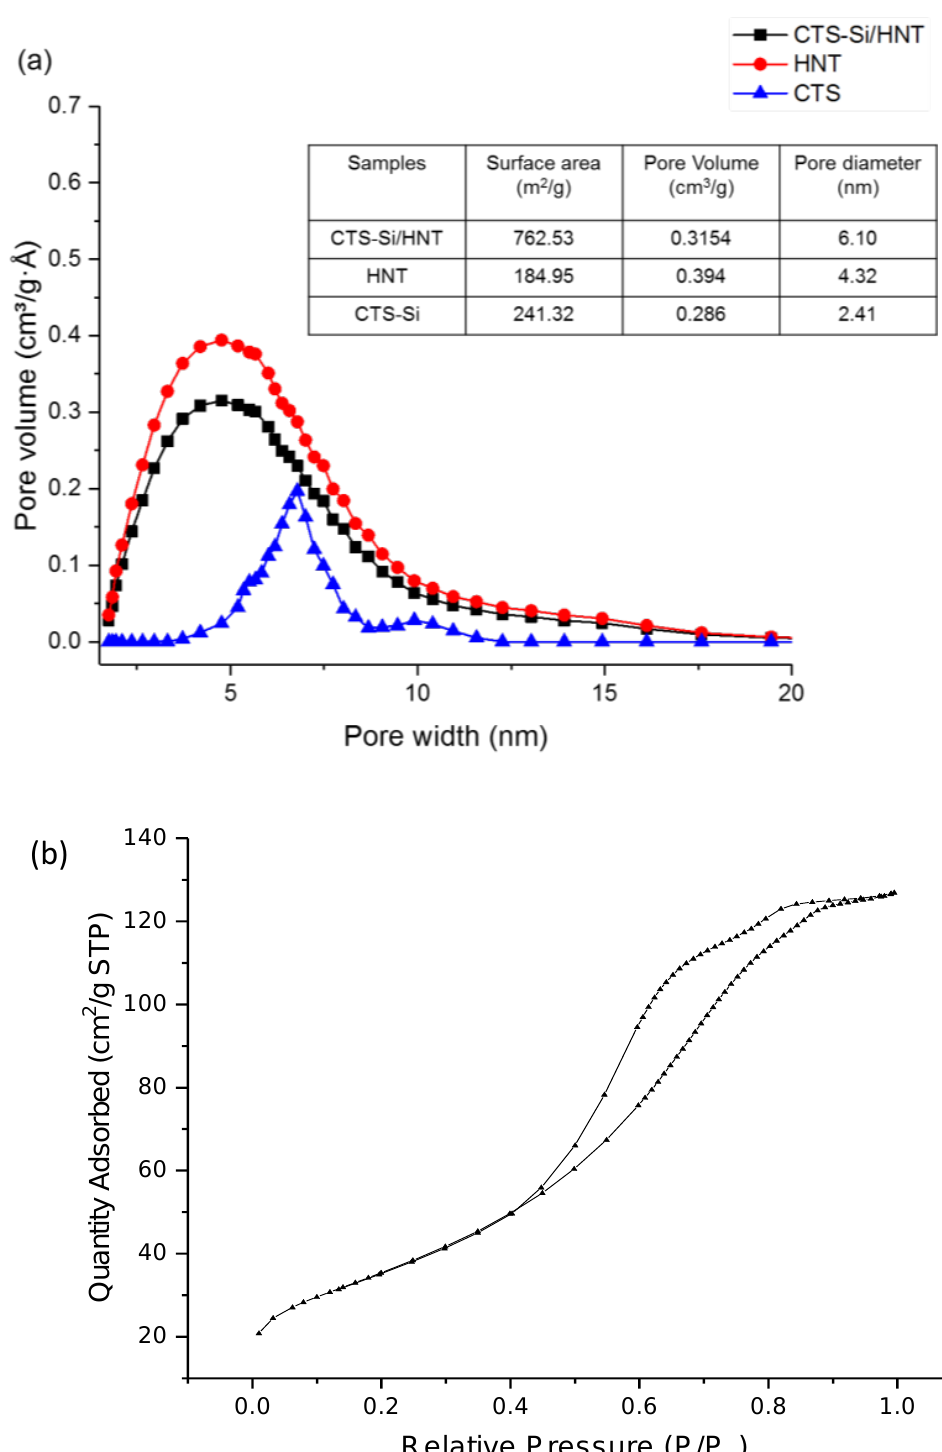
Figure 2. ( a ) Pore distribution of CTS-Si/HNT in comparison to CTS and HNT and ( b ) N 2 isotherm adsorption of CTS-Si/HNT nanocomposite.